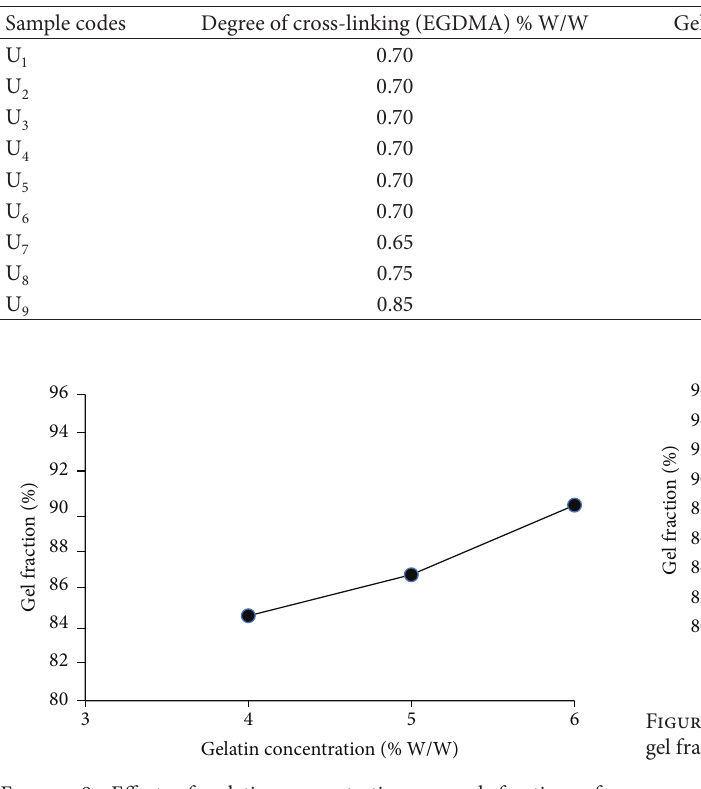
Figure 9: Effect of gelatin concentration on gel fraction of AA/Gelatin hydrogels.